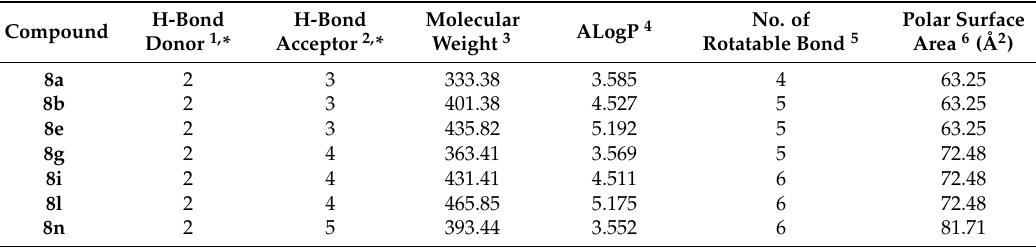
Table 6. Lipinski rule of five parameters results for all the synthesized